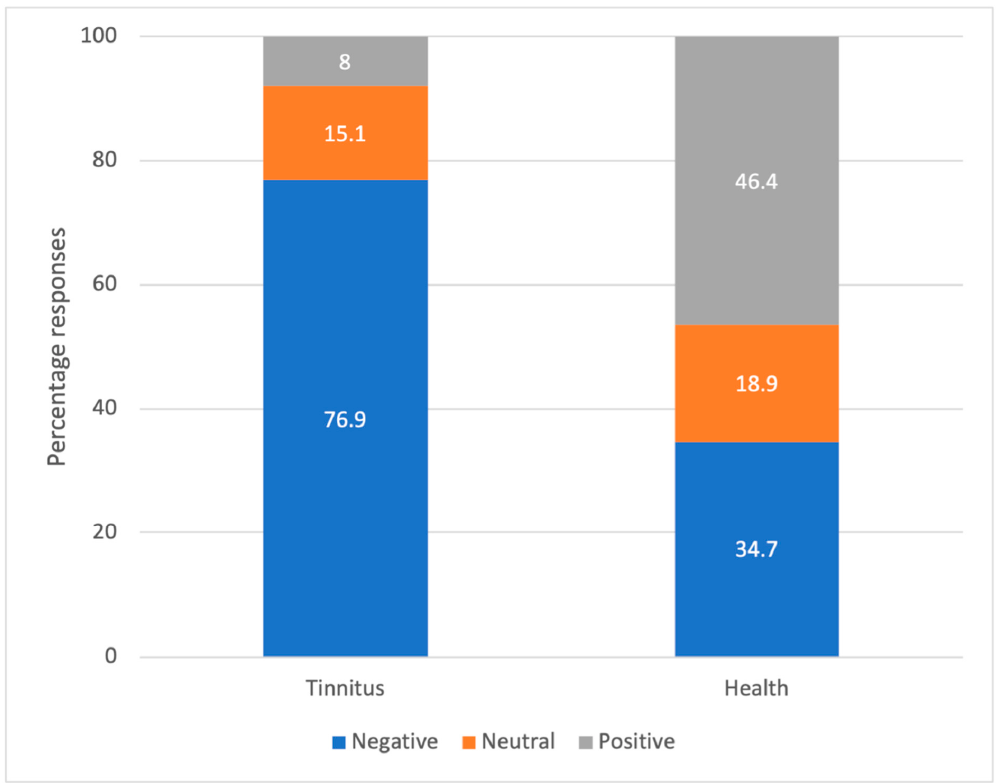
Figure 1. Percentages of associations ranked positive, neutral, and negative for responses to free association task about tinnitus and health.